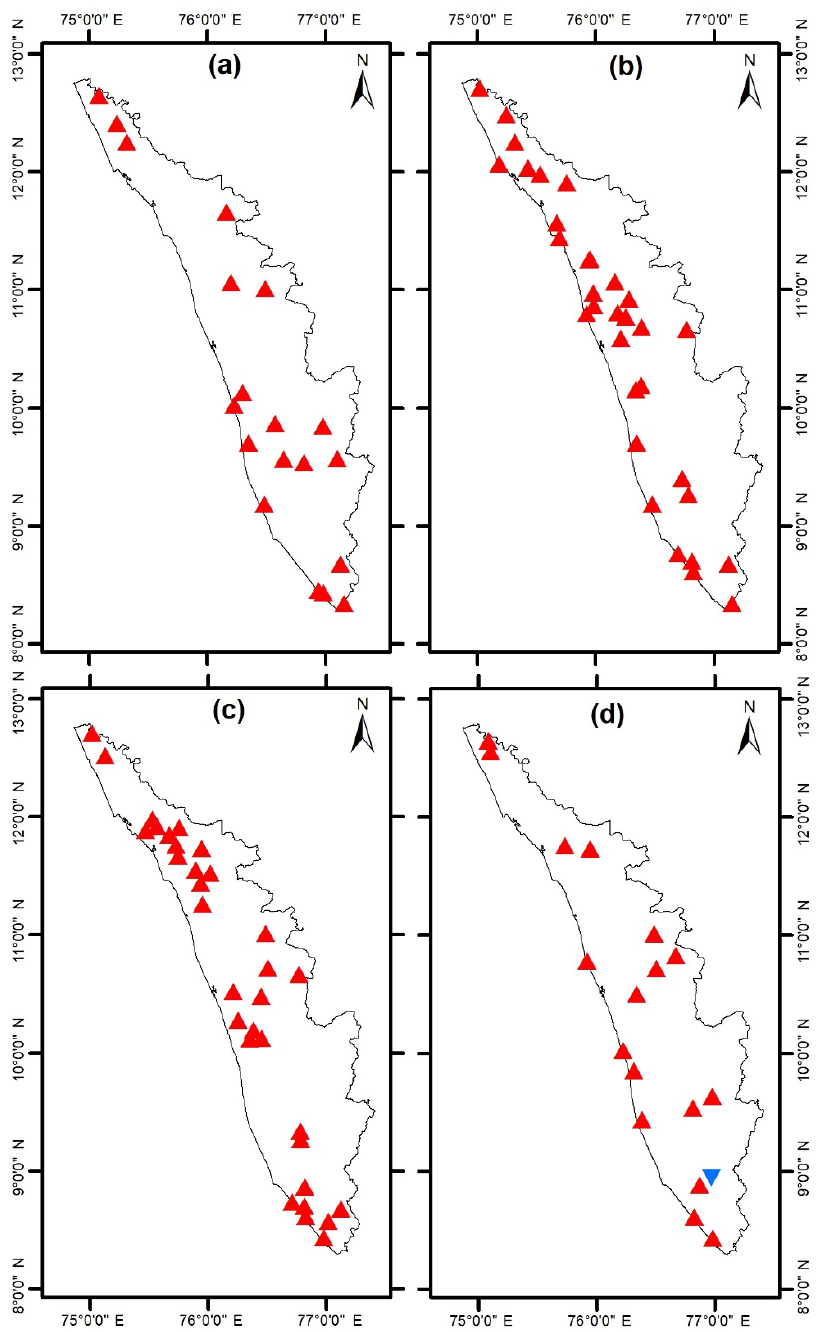
Figure 10. The positive (red) and negative (blue) temperature trend of locations 19-32-26-18 during ( a ) January, ( b ) April, ( c ) August, and ( d ) November.